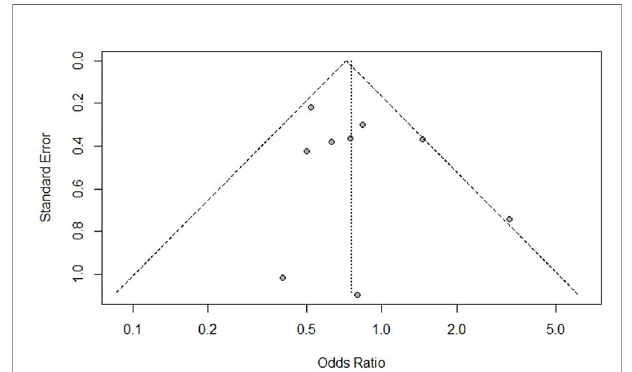
FIGURE 3 | Funnel plot for readmission.